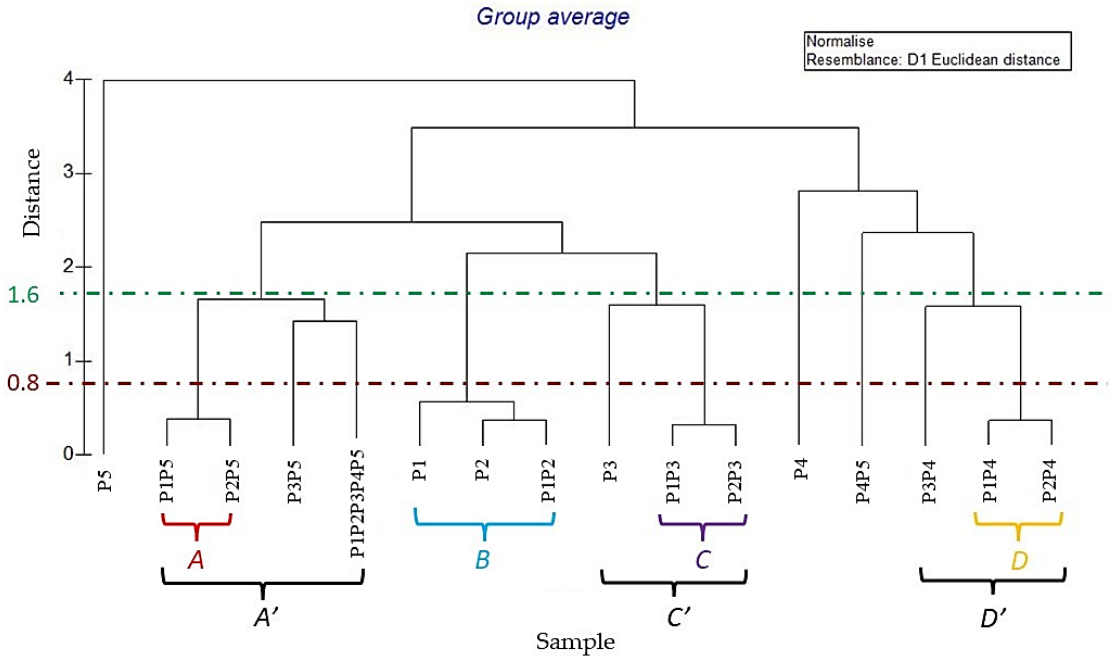
Figure 3. Dendrogram obtained by Hierarchical Cluster Analysis (HCA) based on the Euclidian distances. The samples’ codes are reported in Section 2.1: Plant Material.